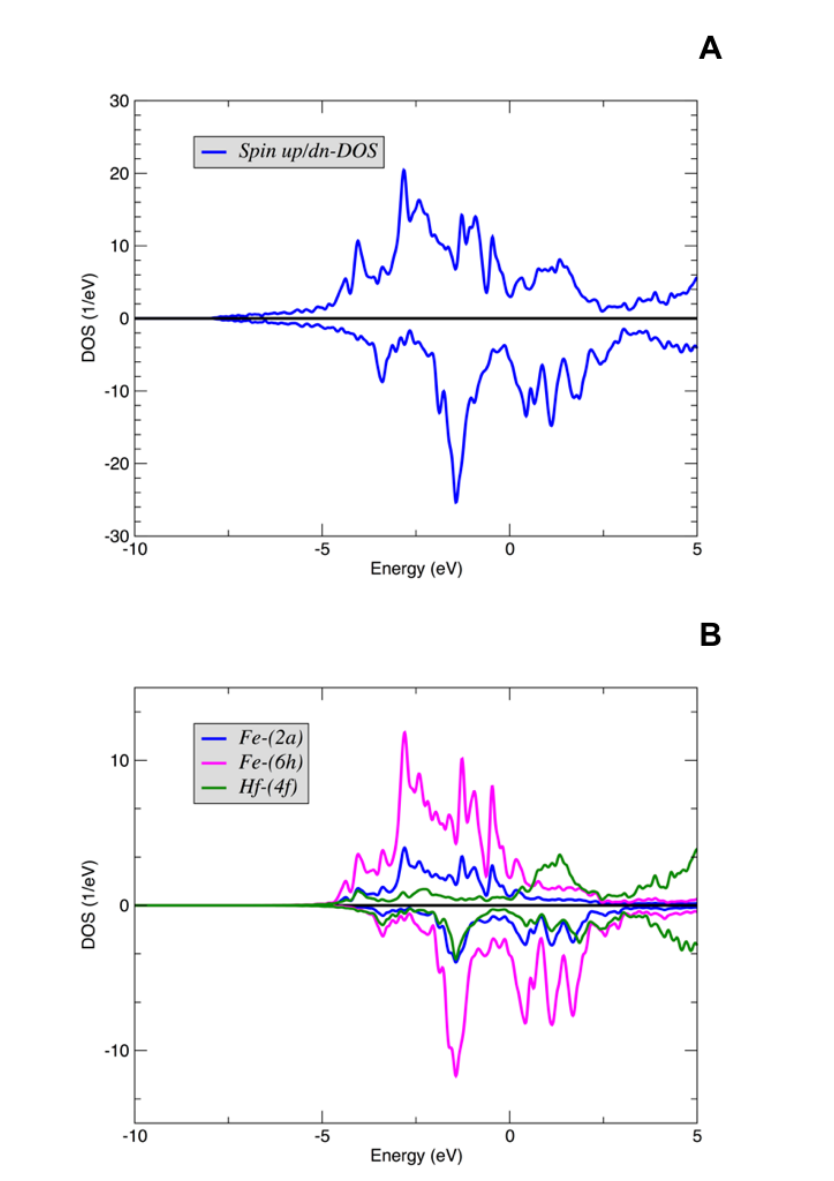
Figure 2. Density of states (DOS) of the Fe 2 Hf: ( A ) Spin-projected total DOS. ( B ) Spin-projected DOS for the d -states of Fe and Hf atoms in different Wyckoff positions. The Fermi level E F is set to E F =